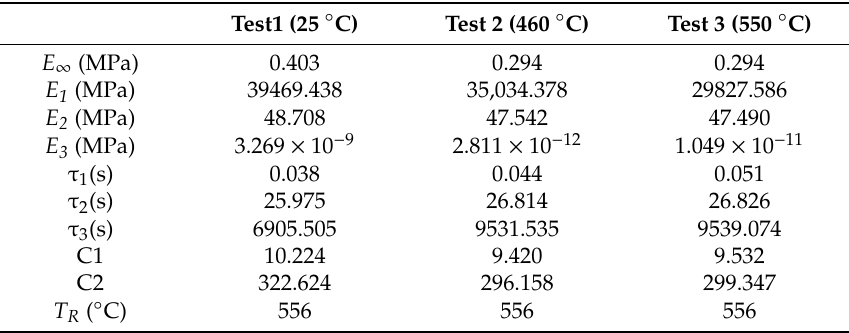
Table 2. The numerical fitting results of the creep compliance.